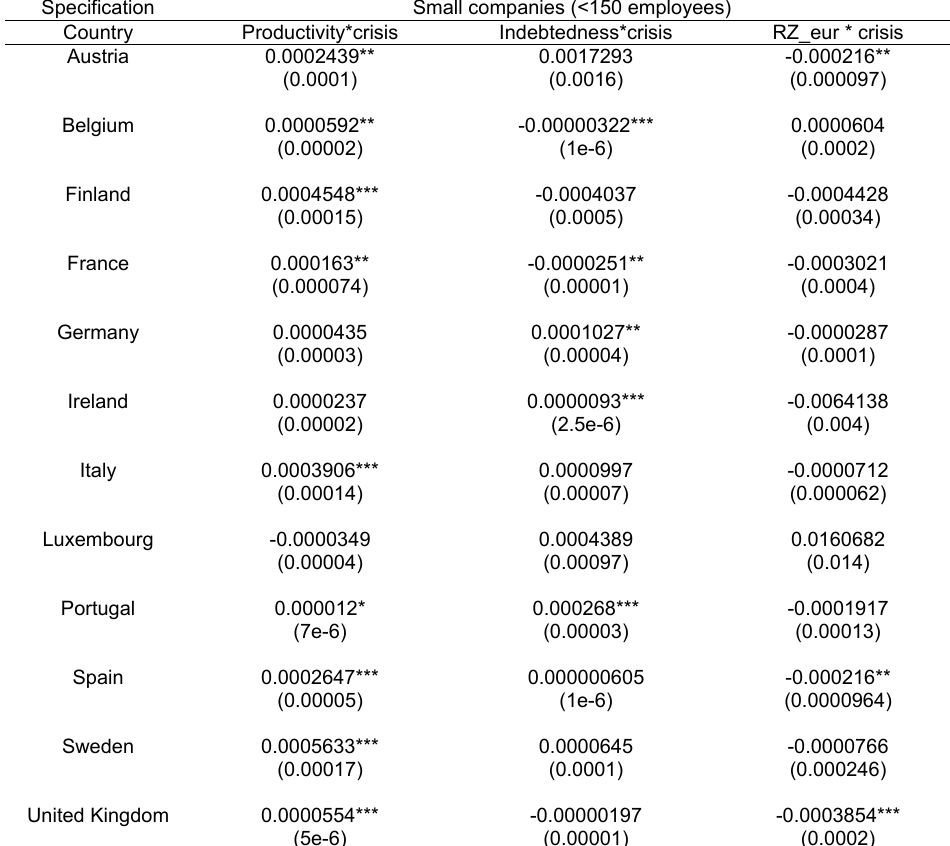
Table A.6. Cross-country effects (small